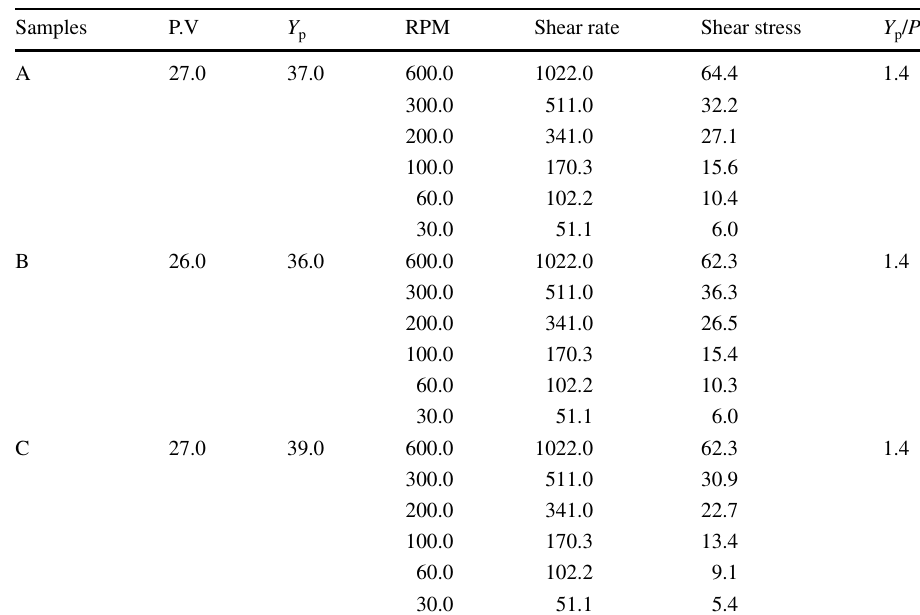
Table 16 Rheology property of the proposed viscosifier at 10 g